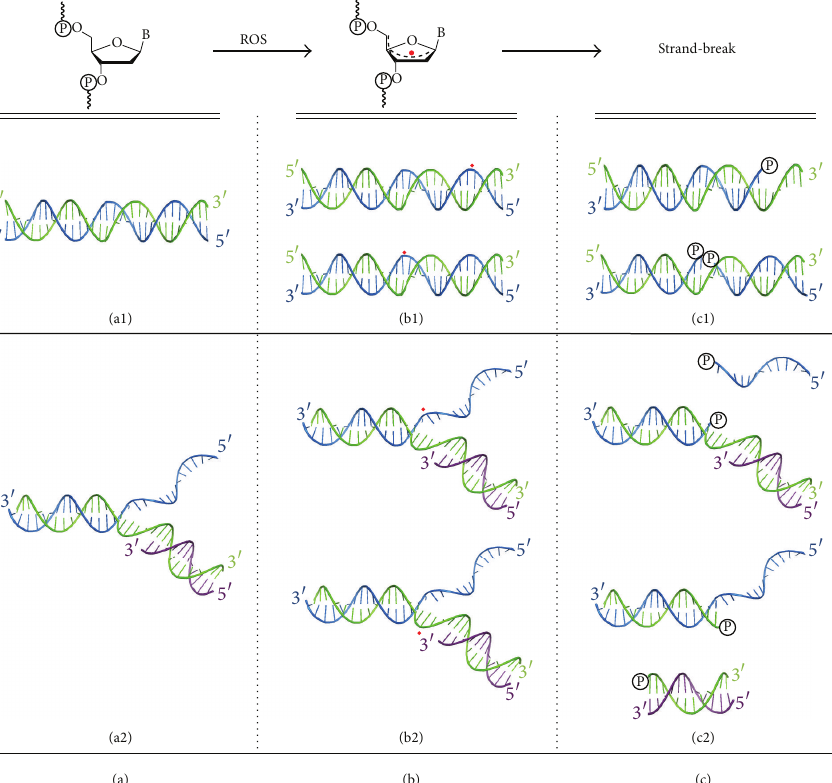
Figure 1: Hydrogen atom abstraction at a 2 󸀠 -deoxyribose moiety in DNA replication relevant architectures. (a) Model replication substrates: duplex (a1) and flap (a2). (b) 2 󸀠 -Deoxyribose radical intermediates in duplex (b1) and flap substrates (b2). (c) Strand-break products resulting from oxidative sugar damage in duplex (c1) and flap substrates (c2).